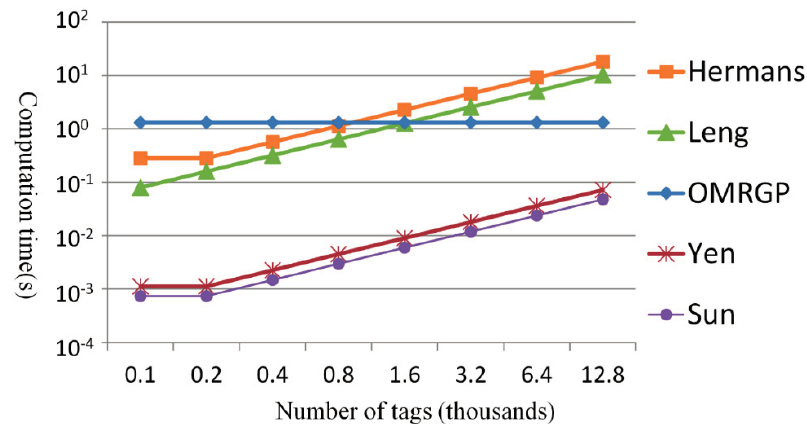
Figure 8. Comparing the computational load of the tags.